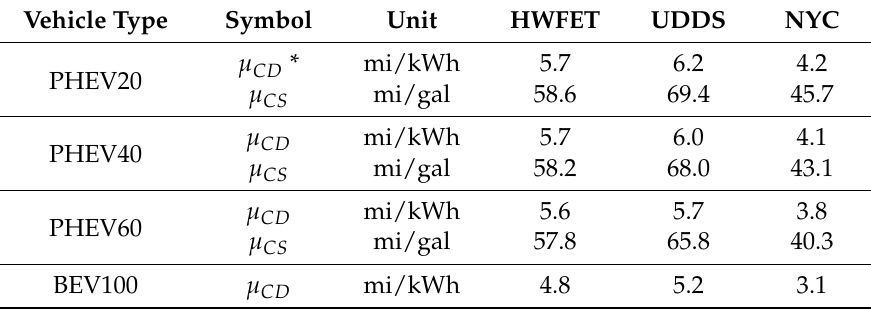
Table 1. The specifications of the electrified vehicles used for the case study. HWFET: highway fuel economy test; UDDS: urban dynamometer driving schedule; NYC: New York